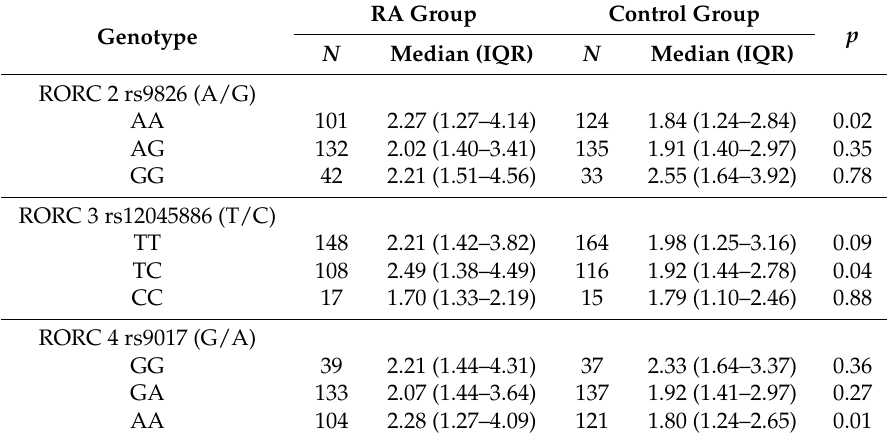
Table 7. Variation in RORc expression levels in RA patients and control group in relation to RORc2 gene